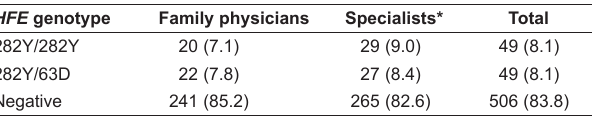
TABle 2 Clinical characteristics according to HFE test